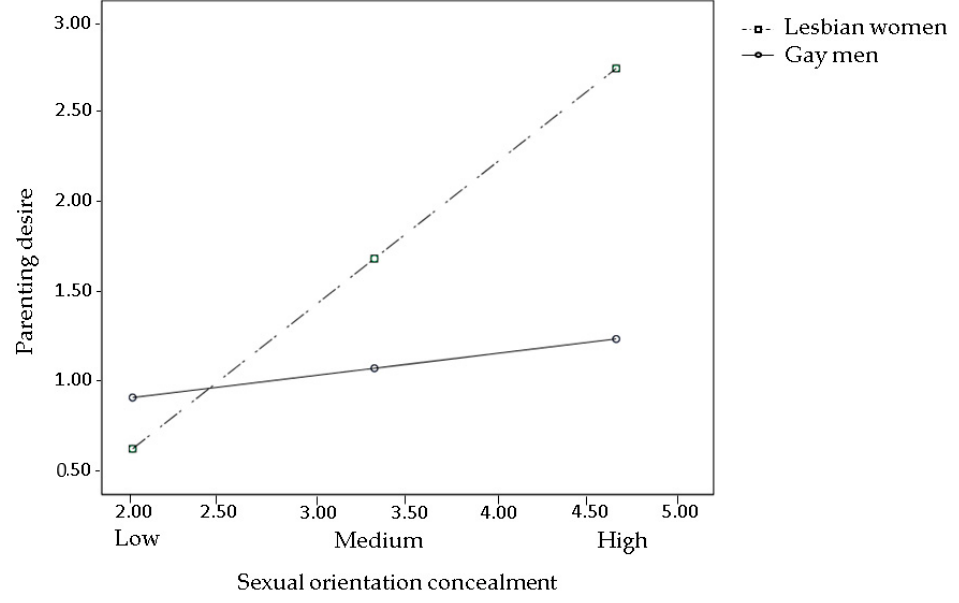
Figure 3. Interaction between sexual orientation concealment and gender on parenting desire. Estimated log odds of parenting desire are reported for combinations of sexual orientation concealment (low, medium, and high) and individual’s gender (lesbian women vs. gay men).